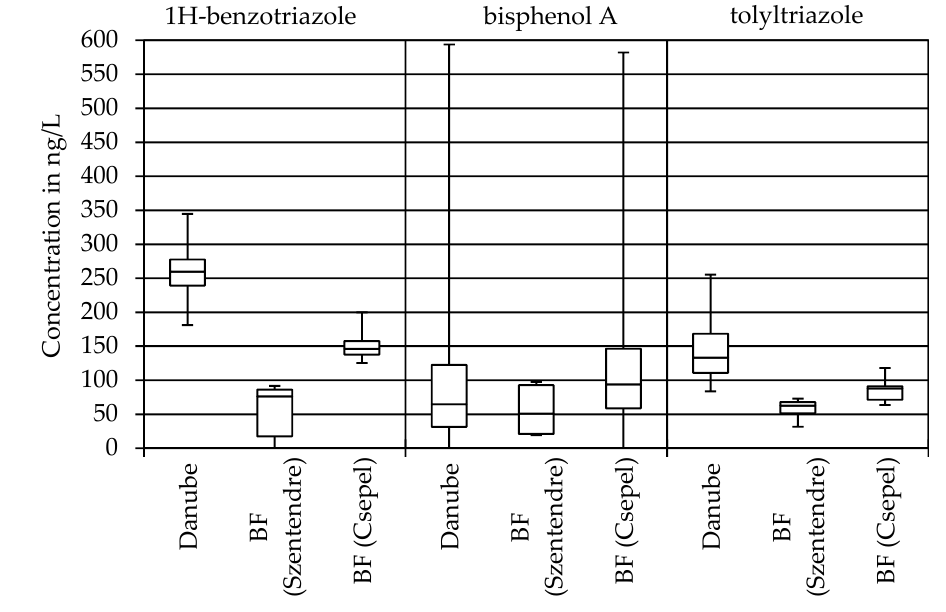
Figure 2. Boxplots representing concentrations of industrial chemicals in the Danube River water and bank filtrate.